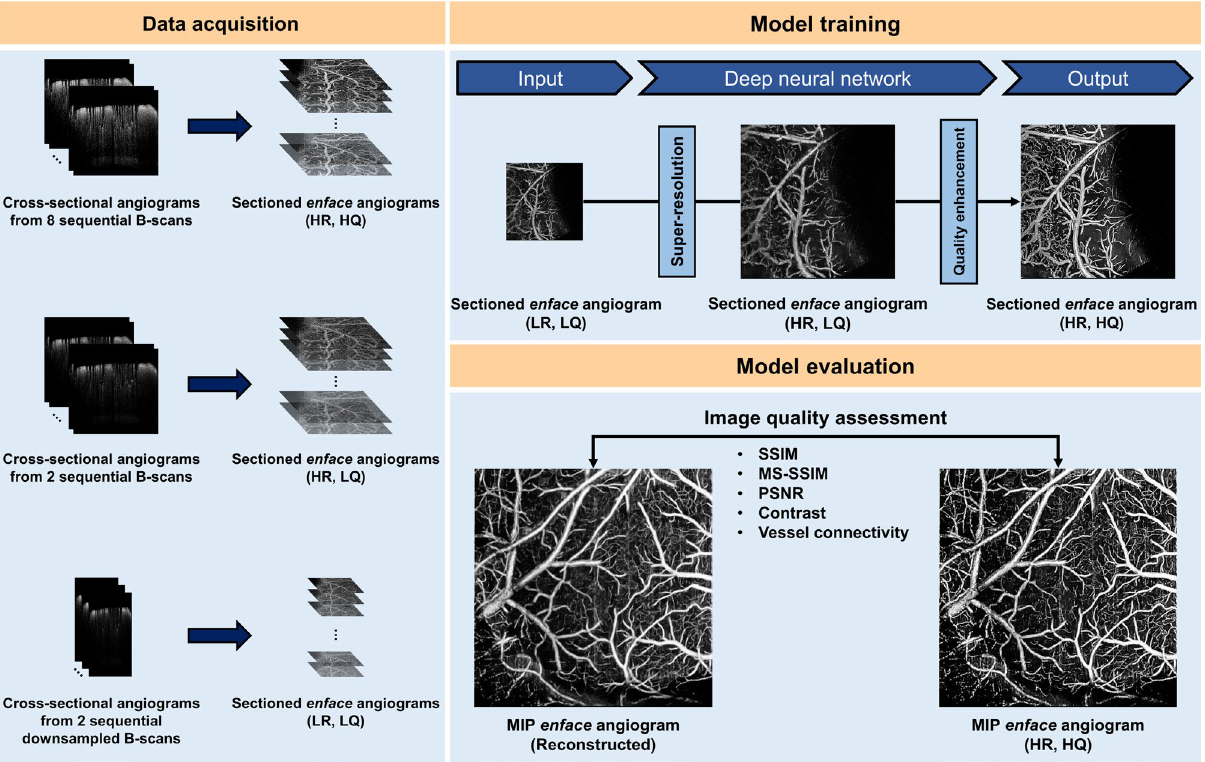
Figure 1. Schematic of our deep learning (DL) framework for accelerated optical coherence tomography angiography (OCTA). (LR, LQ) low-resolution and low-quality, (HR, LQ) high-resolution and low-quality, (HR,